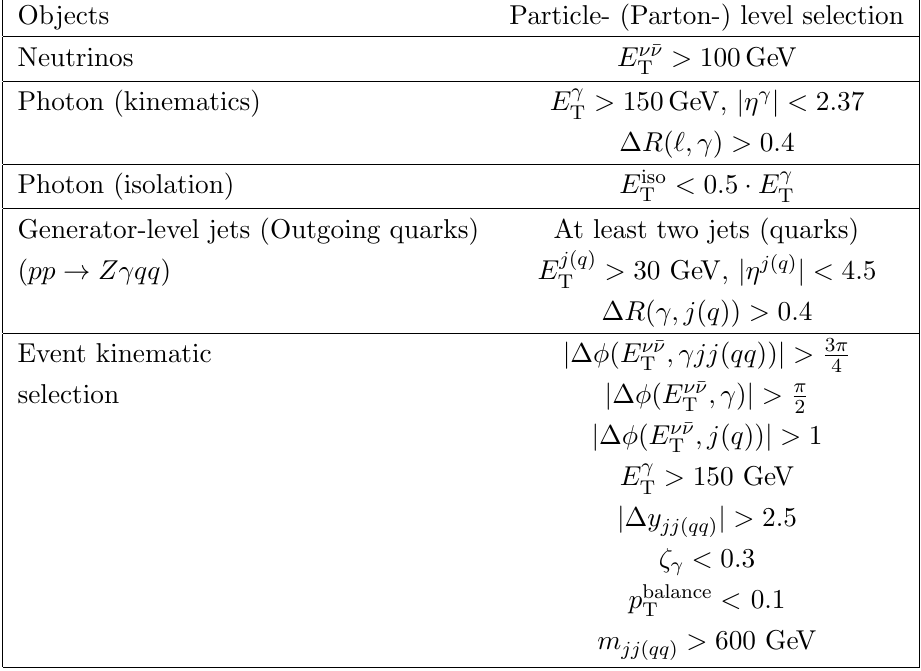
Table 8 . Neutrino channel aQGC region de(cid:12)nition at particle (parton) level. If there are more than two jets at particle level, the two highest transverse momentum ones are